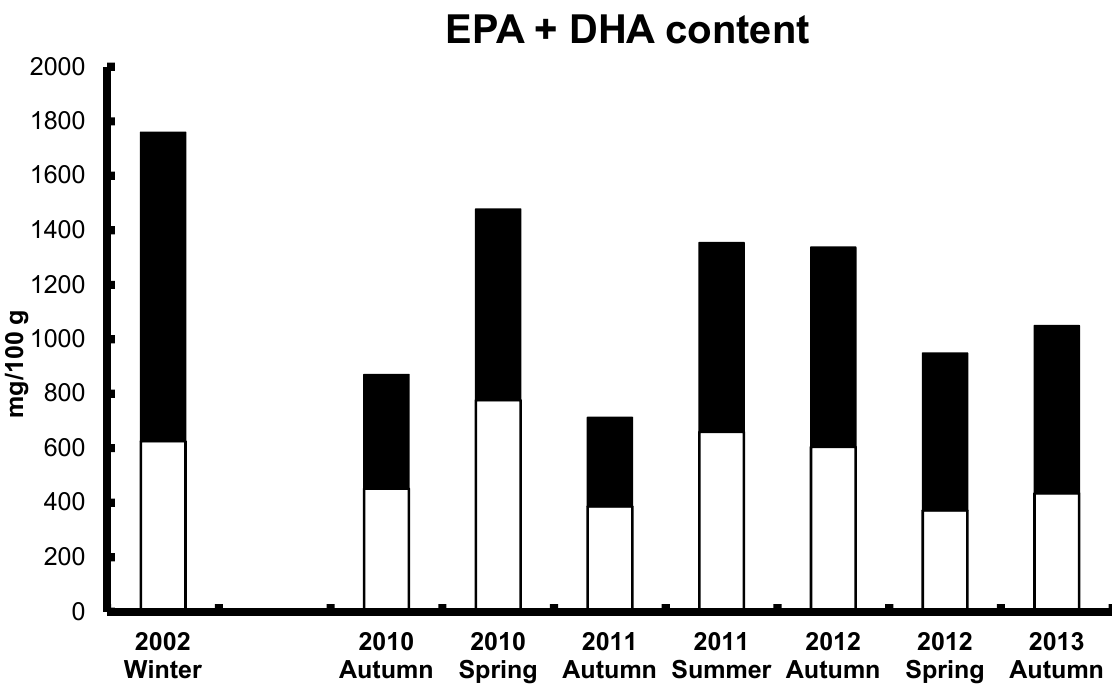
Figure 5 . Farmed Atlantic salmon from Tasmania, Australia from 2002 (fish oil diet) [23] and 2010 to 2013 (chicken fat/fish oil diet) [108]: Content of EPA ( white bars ) and DHA ( black bars ) (mg/100 g, wet